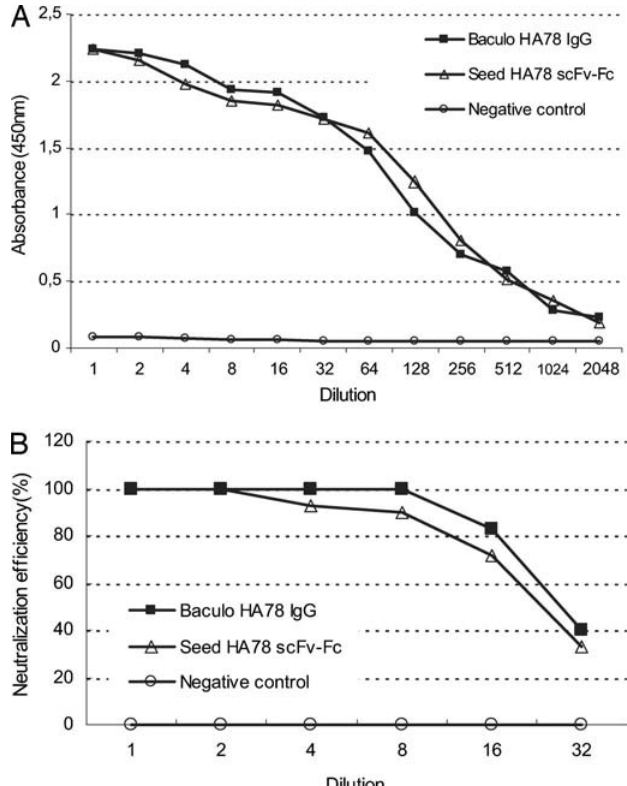
Fig. 3. Functional analysis of seed-produced HA78. ( A ) ELISA analysis of antigen-binding activity of HA78 produced and purified from transgenic Arabidopsis seed. ELISA was conducted with 96-well plates coated with HAV antigen purified from the Chinese strain JN. Seed HA78 scFv-Fc, 100 (cid:3) l (2.5 (cid:3) g/ml) of purified HA78 from transgenic Arabidopsis seed; Baculo HA78 IgG, 100 (cid:3) l (2.5 (cid:3) g/ml) of purified anti-hepatitis HA78 IgG from the baculovirus- infected insect cell supernatant; negative control, 100 (cid:3) l of PBS. ( B ) In vitro neutralizationactivityof Arabidopsis seed-producedHA78againstHAVstrain JN. A dose of 50 (cid:7) TCID 50 of HAV strain JN was incubated with a 2-fold serial dilution of ProtA-purified Arabidopsis HA78 antibody (seed HA78 scFv-Fc), purified full-length anti-HAV HA78 IgG (baculo HA78 IgG), and anti-HTNV AH100 IgG (negative control), starting from 80 (cid:3) g/ml for all three antibodies. After inoculation of FRhK-4 cells with the virus-antibody mix and 21 days of growth, cells were harvested, and the presence of HAV was monitored by